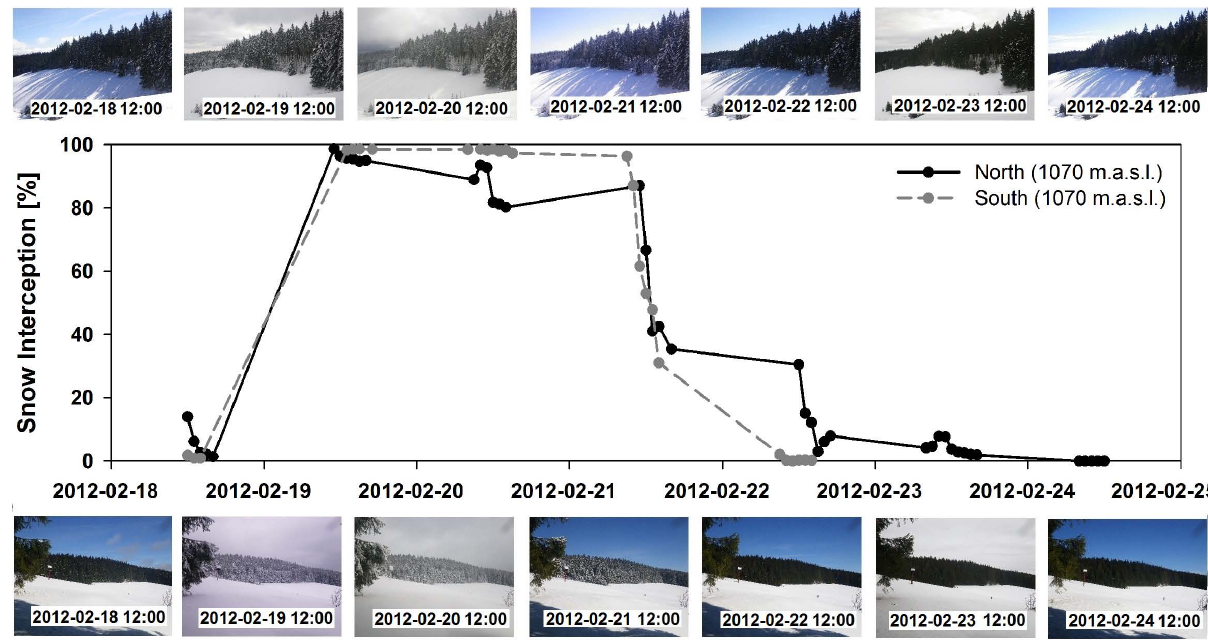
Fig. 10. Snow interception as percentage of white pixels in the ROI in the conifer forest canopy of a north facing and a south facing slope, respectively.